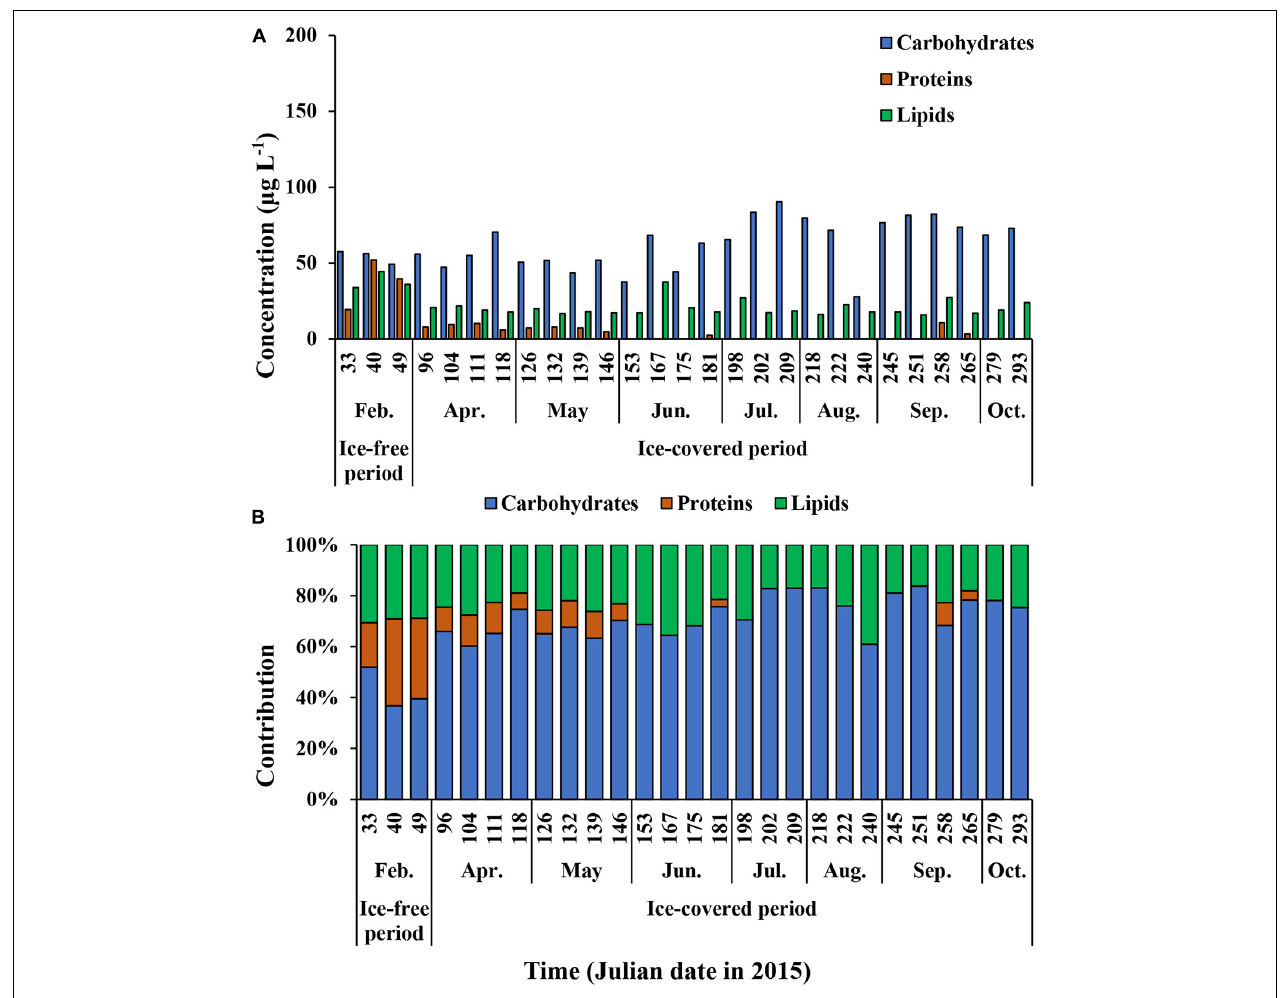
FIGURE 9 | The carbohydrates, proteins, and lipids concentrations (A) and the contribution of each biochemical component of pico-sized (0.7–2 µ m) POM (B) at JBS during the entire study period,